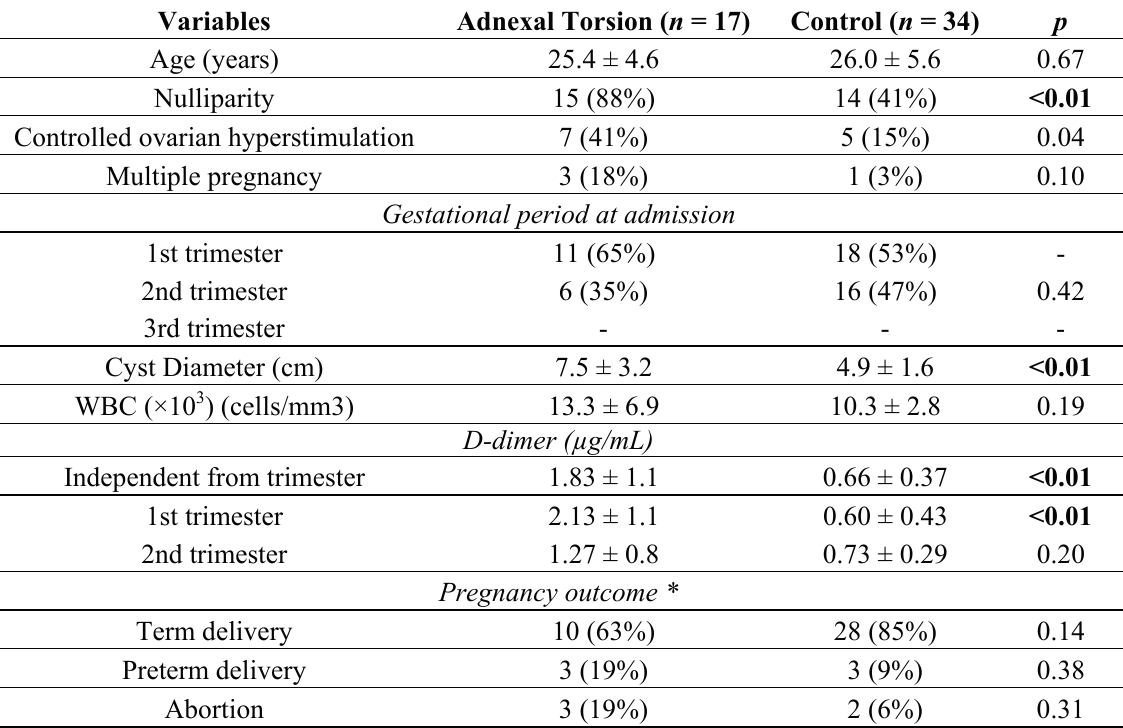
Table 1. Comparison of clinical characteristics and pregnancy outcome between groups.